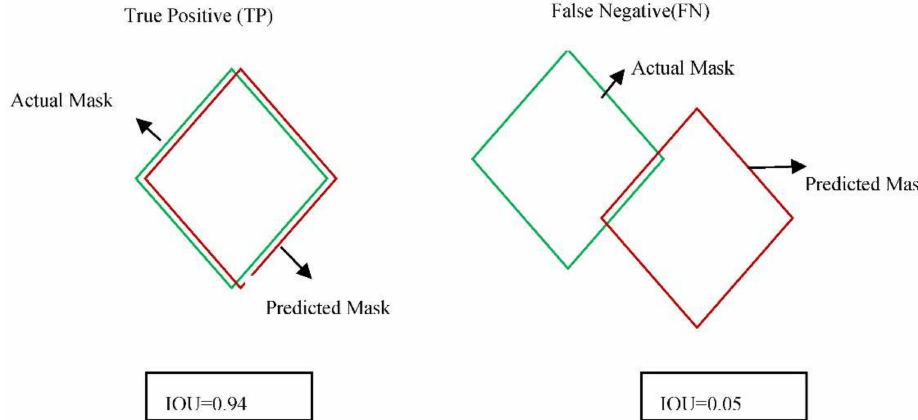
Figure 12. TP and FN prediction based on